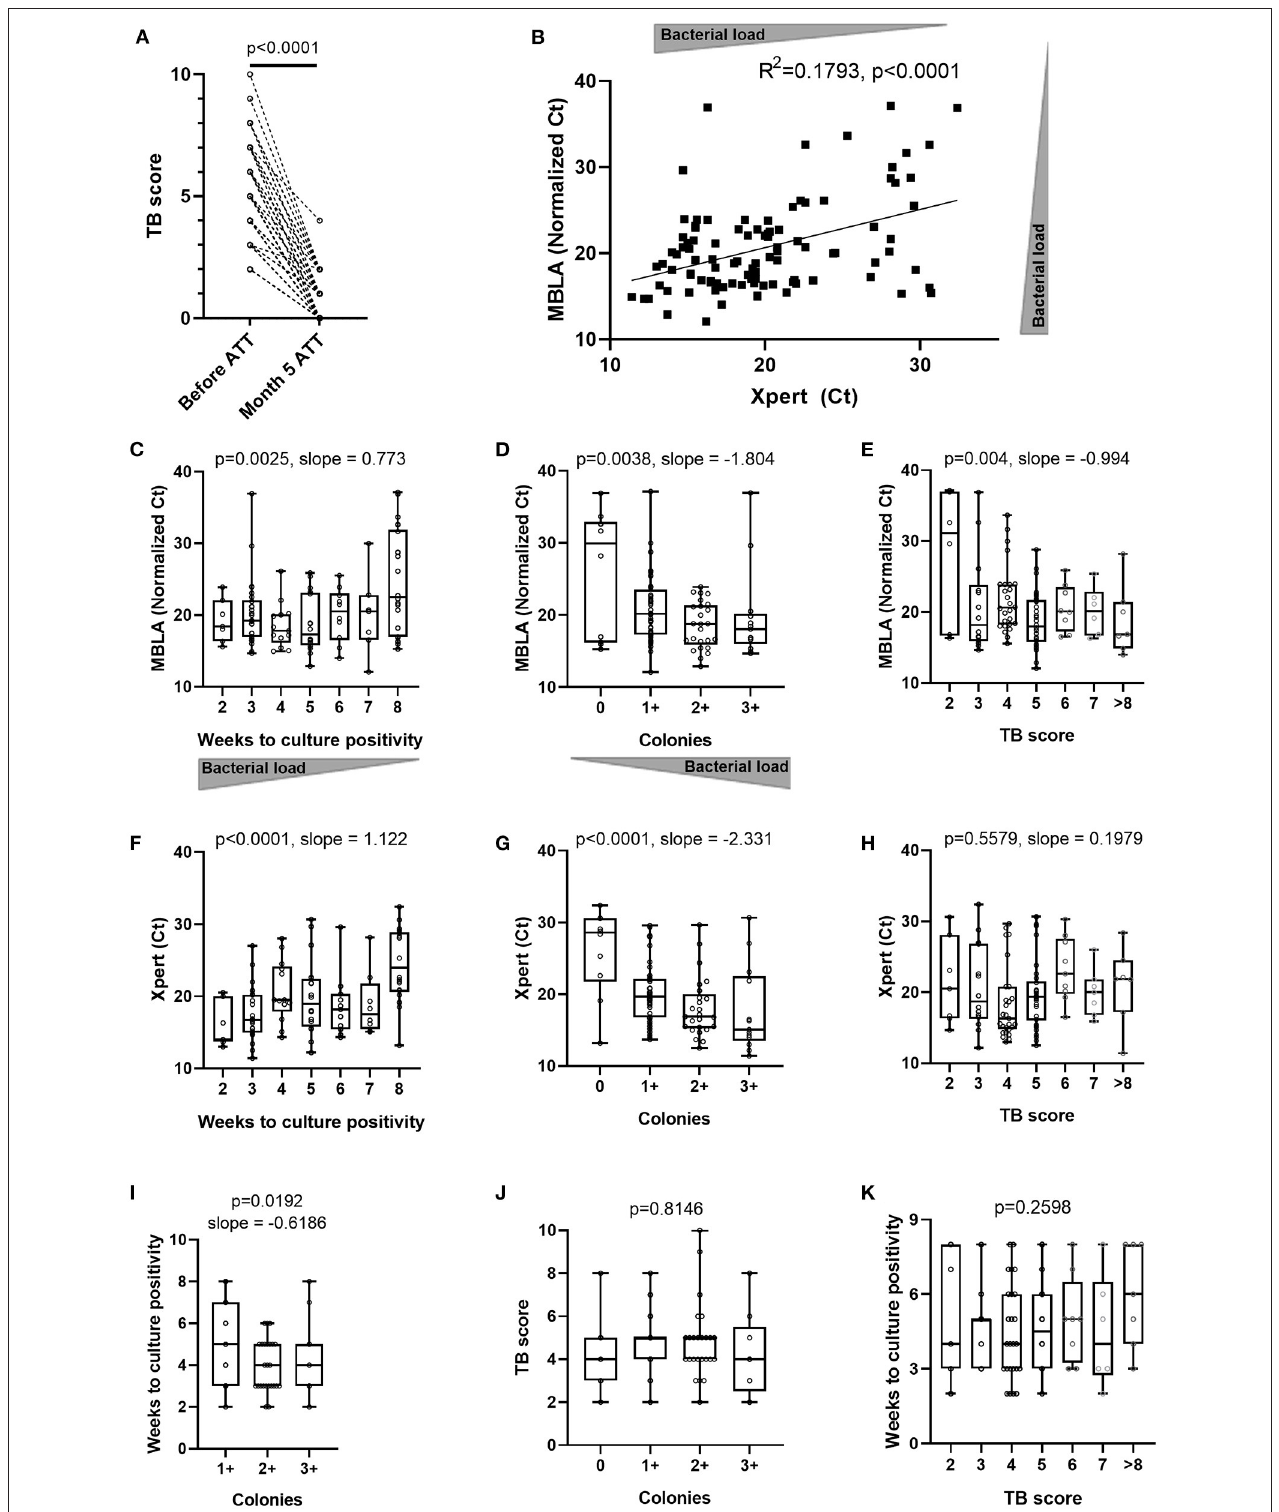
FIGURE 1 | Concordance between various estimates of sputum bacterial load and clinical assessment of disease severity across TB patients at time of diagnosis and after 5 months of antibiotic treatment. (A) Evolution of clinical TB score after 5 months of anti-tuberculous treatment (Month 5 ATT) (Wilcoxon matched-pairs signed rank test p -value). Sputum molecular bacterial load assay (MBLA) results from specimens before initiation of anti-tuberculous treatment (ATT) against: (B) Xpert